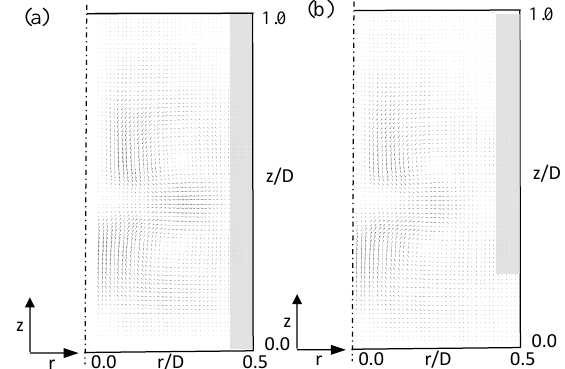
with Particle Image Velocimetry in z-r cross-section plane and for tree rotational speeds N =100, 200, 300 rpm, for the 4 positions of baffles from bottom of the vessel s =0, s=¼H, s= 1 / 3 H, s=½H, the length of the baffle respectively is: L=H, L=3/4H, L=2/3H, L= 1/2H.